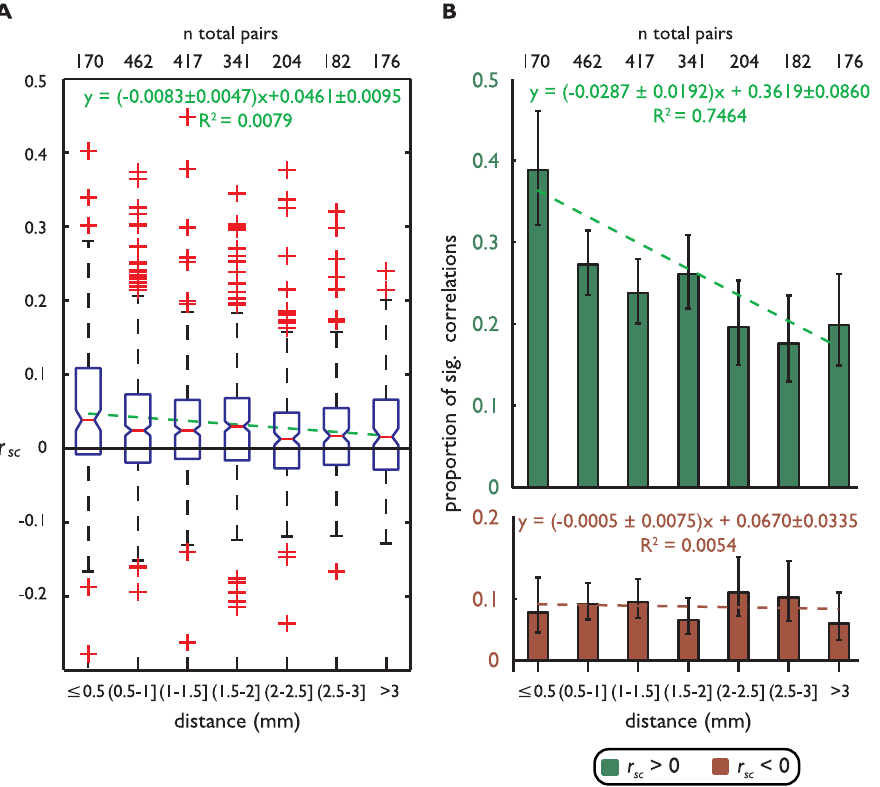
Figure 4. Spike count correlations between all neurons as a function of inter-neuron distance. A ) Distribution of Fisher-transformed r sc for all correlations (ordinate) as a function of distance between neurons (abscissa). Each bar indicates the median (red line), the box indicates the center 50%, and the whiskers extend to approximately 6 2.7 s . Crosses indicate outliers beyond this interval. The green line and equation represent the best line fit through the data. The 95% confidence intervals for the slope are indicated. The total number of pairs is shown on the top B ) Proportion of significant positive and negative correlations as a function of distance between units for r sc (see legend). The green and red lines represent best-fit lines for these proportions. The equations for the two lines and 95% confidence intervals for the slopes are shown. There is a significant negative effect of distance on the proportion of significant positive correlations, and no significant effect of distance on the proportion of significant negative correlations ( p =0.019 and p =0.876, respectively, F-test for both). The error bars indicate the 95% confidence intervals for the proportions. The total number of pairs is shown on the top.